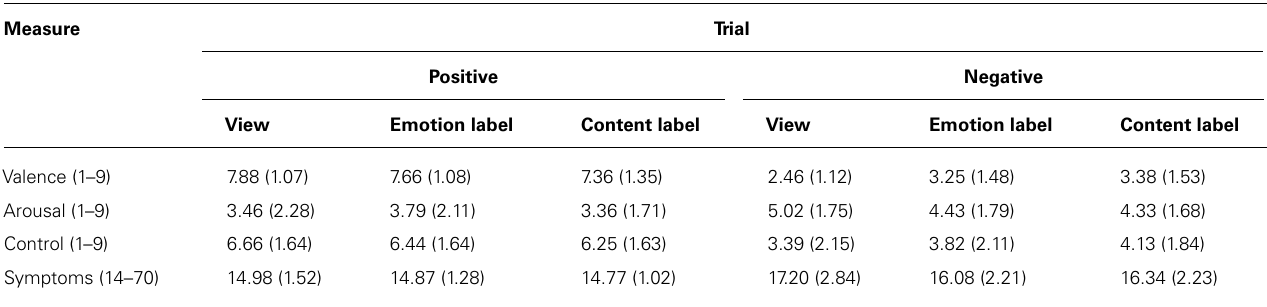
Table 2 | Means and SDs for all dependent variables of theAffect Labeling task ( N =